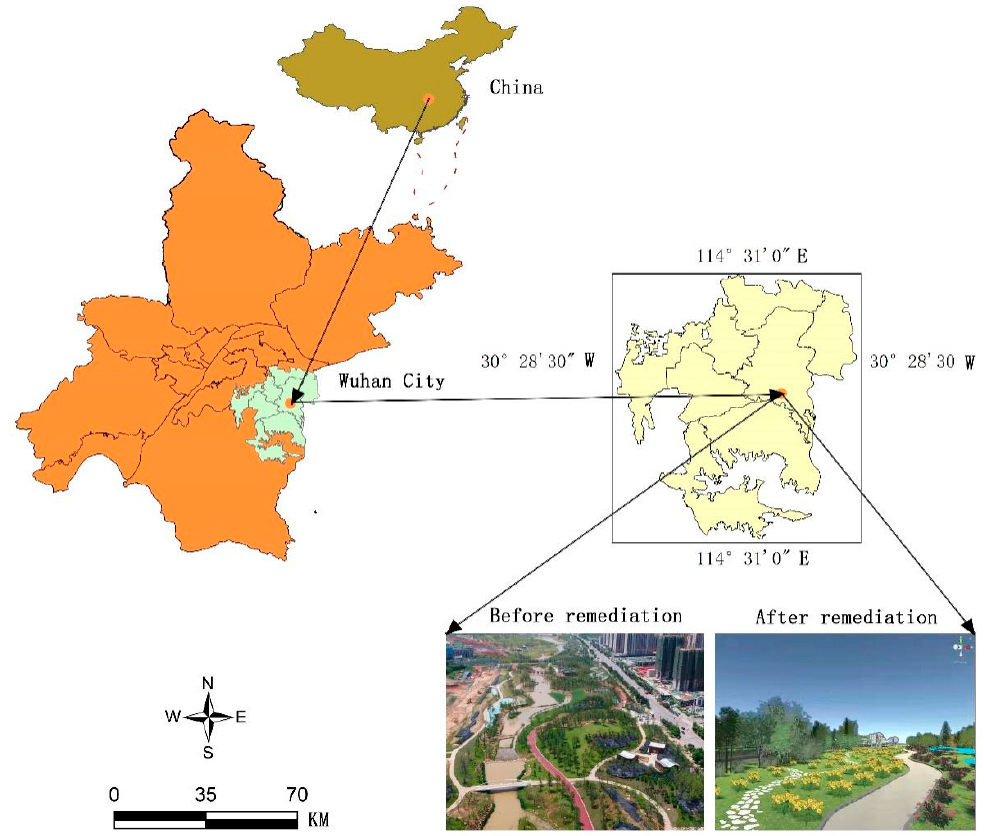
Figure 1. Location overview of study area in National High-Tech Zones. Source: Shot by DJI Inspire 2 (DJI Technology Co., Ltd, Shenzhen, China).